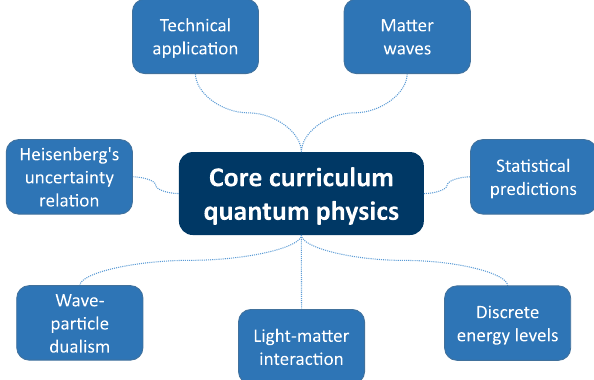
FIG. 1. Core curriculum on quantum physics for secondary school teaching as revealed by Staderman et al.